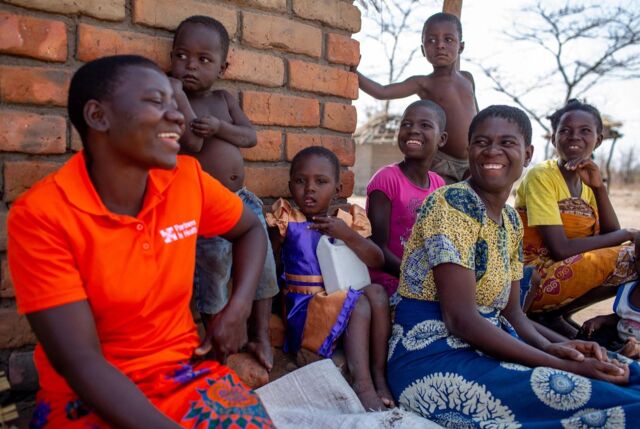
Diagrama of the Partners In Health Household ModelAbbreviation: CHW, community health worker.a Cartoon images courtesy of Mango Tree, Jesse Hamm, Petra Rohr-Rouendaal, and Rebecca Ruhlmann.